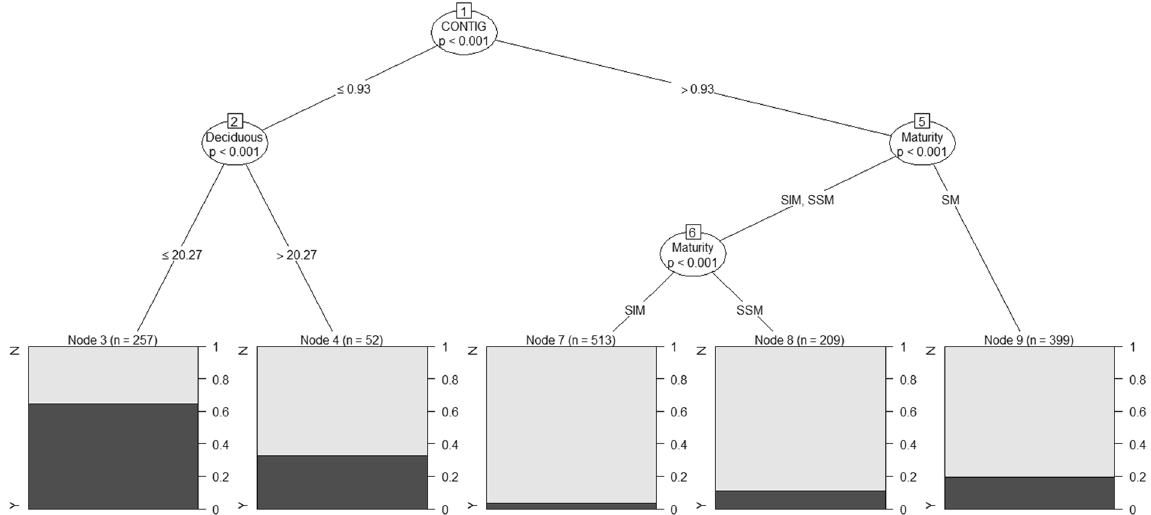
Figure 1. Classification tree showing the relative importance of the different biological and environmental attributes, with statistically significant branches at Nodes, in determining the propensity of male elephants to occur in all-male groups. SIM: Sexually Immature, SM: Sexually Mature but Socially Immature, SSM: Sexually and Socially Mature, A: Musth absent, P: Musth present, Y: Associating in all-male groups, N: Not associating in all-male